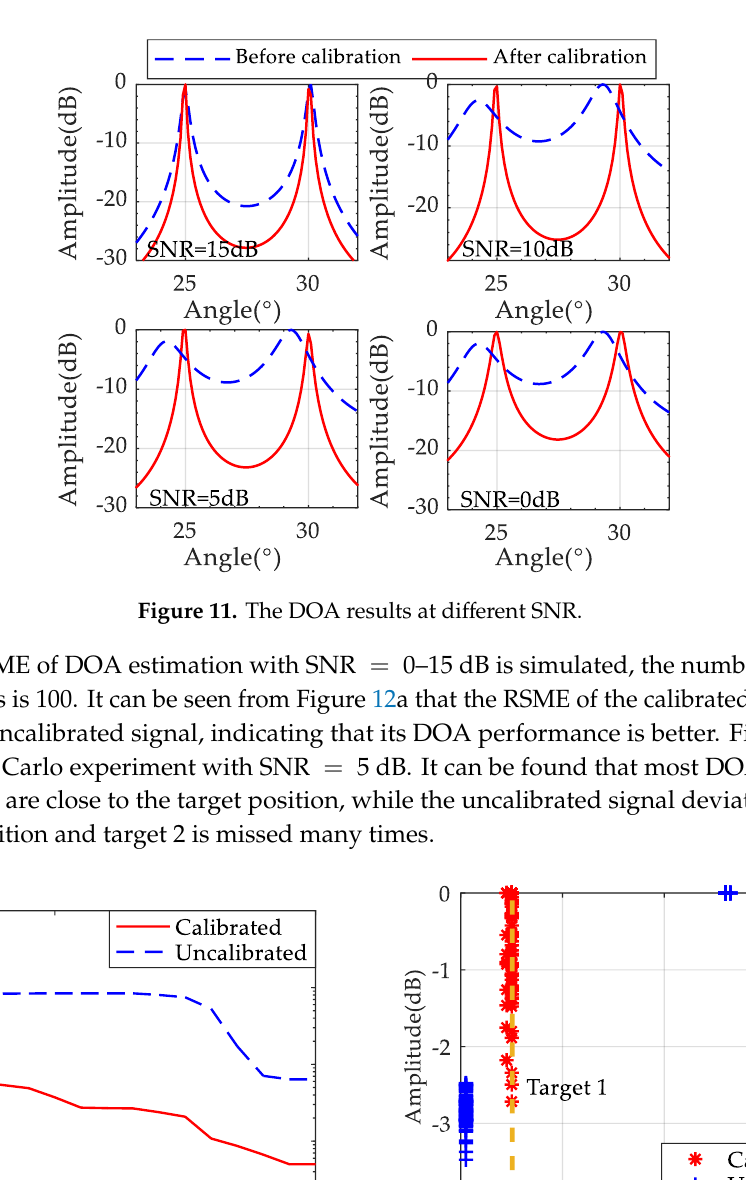
( b ) Figure 10. ( a ) The result of FFT after calibration; ( b ) The DOA results after calibration. 3.4. System DOA Performance after Calibration After calibration, the simulation of the sparse-array TDM MIMO radar system is carried out. Except for the velocity, angle, and SNR, the remaining conditions are the same as the previous simulation parameters. Setting the angles